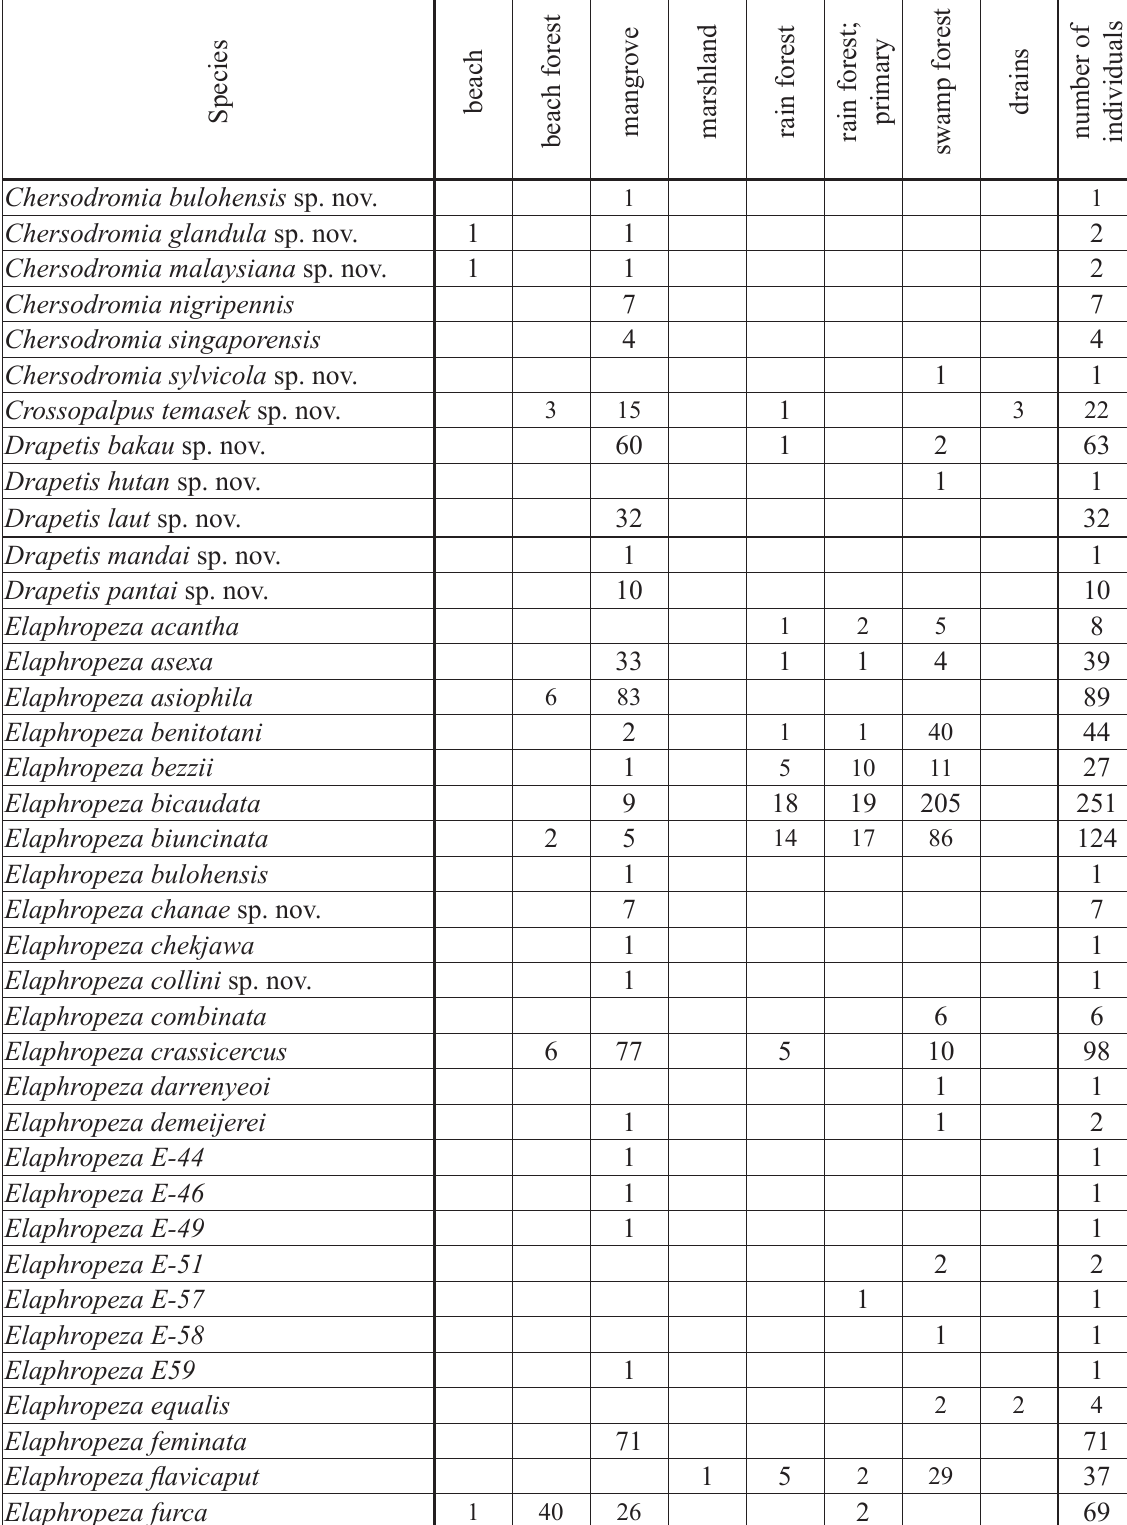
Table 2. Occurrence of the Tachydromiinae per habitat type in Singapore. The figures represent number of individuals observed per